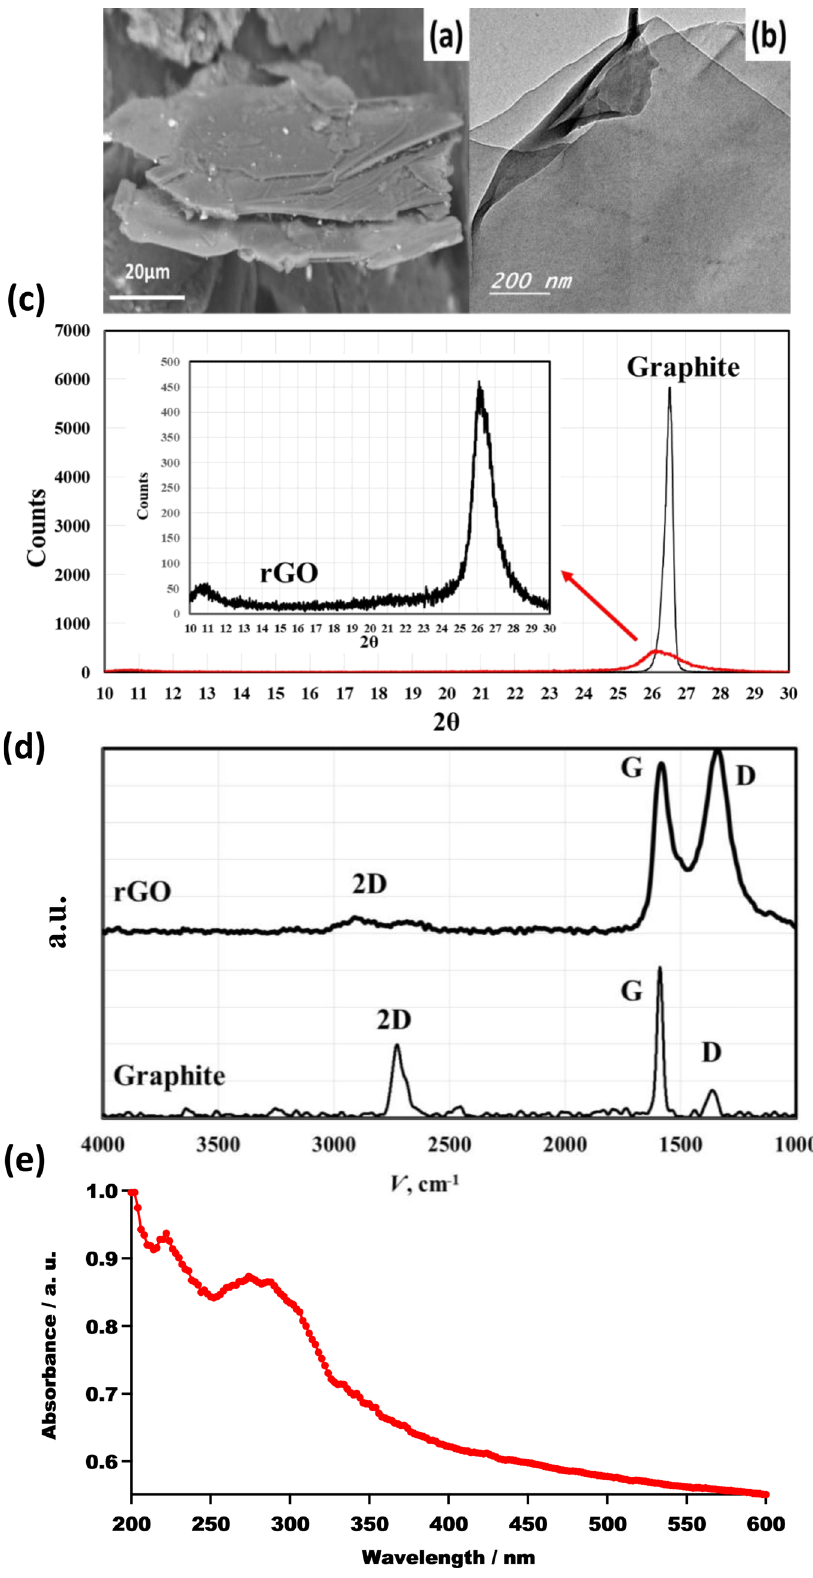
Figure 2. ( a ) SEM micrograph of the graphite precursor, ( b ) TEM micrograph of the produced rGO. ( c ) XRD diffraction pattern of the synthesized rGO. ( d ) Raman spectra of produced rGO compared to graphite precursor. ( e ) UV–Visible absorption spectrum of synthesized